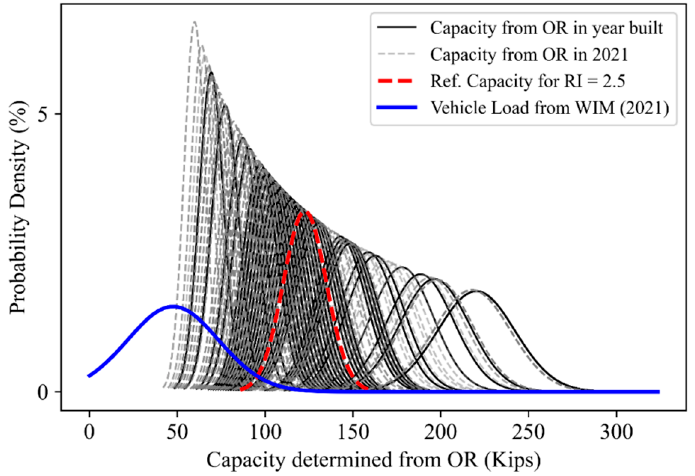
Figure 6. Load and capacity curve of bridges (Site ID: 0210378).